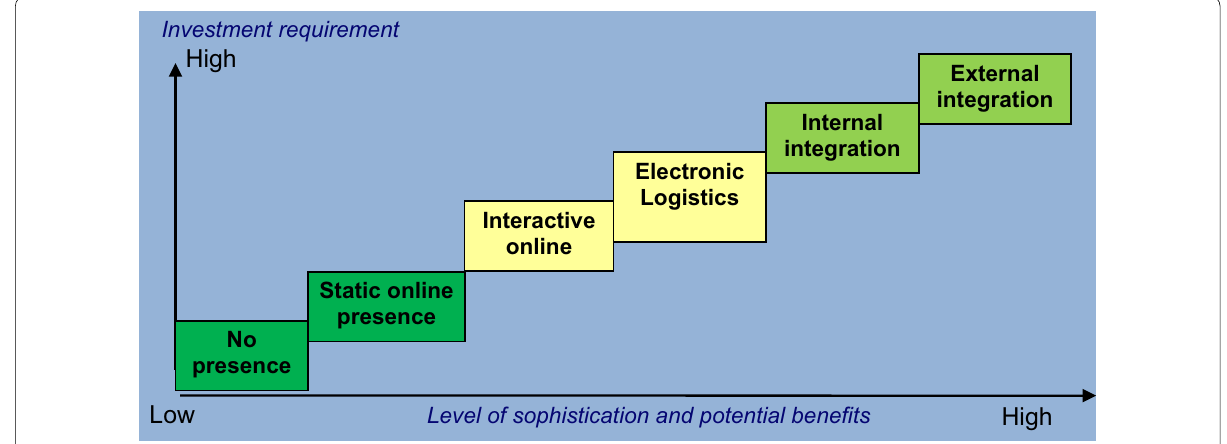
Fig. 1 Stages of growth for e-business (McKay and Marshall